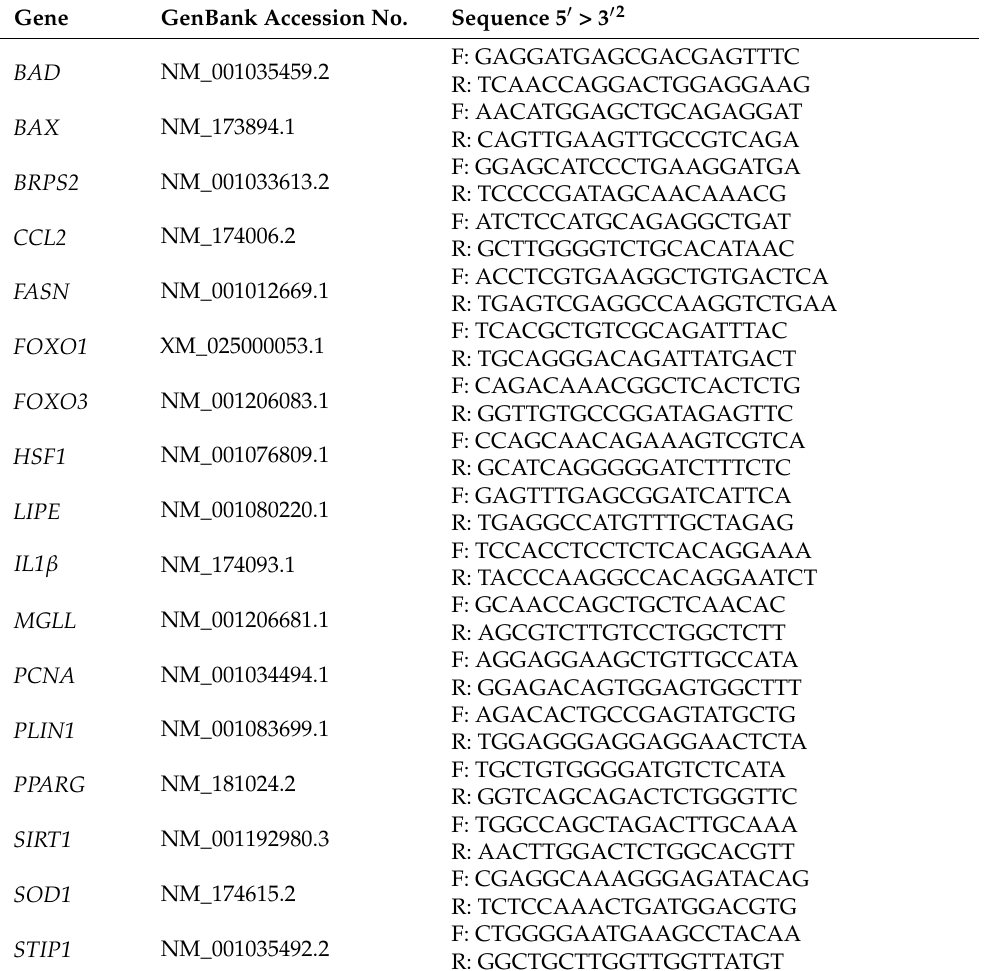
Table 1. List of primers used for mRNA expression in the DFAT